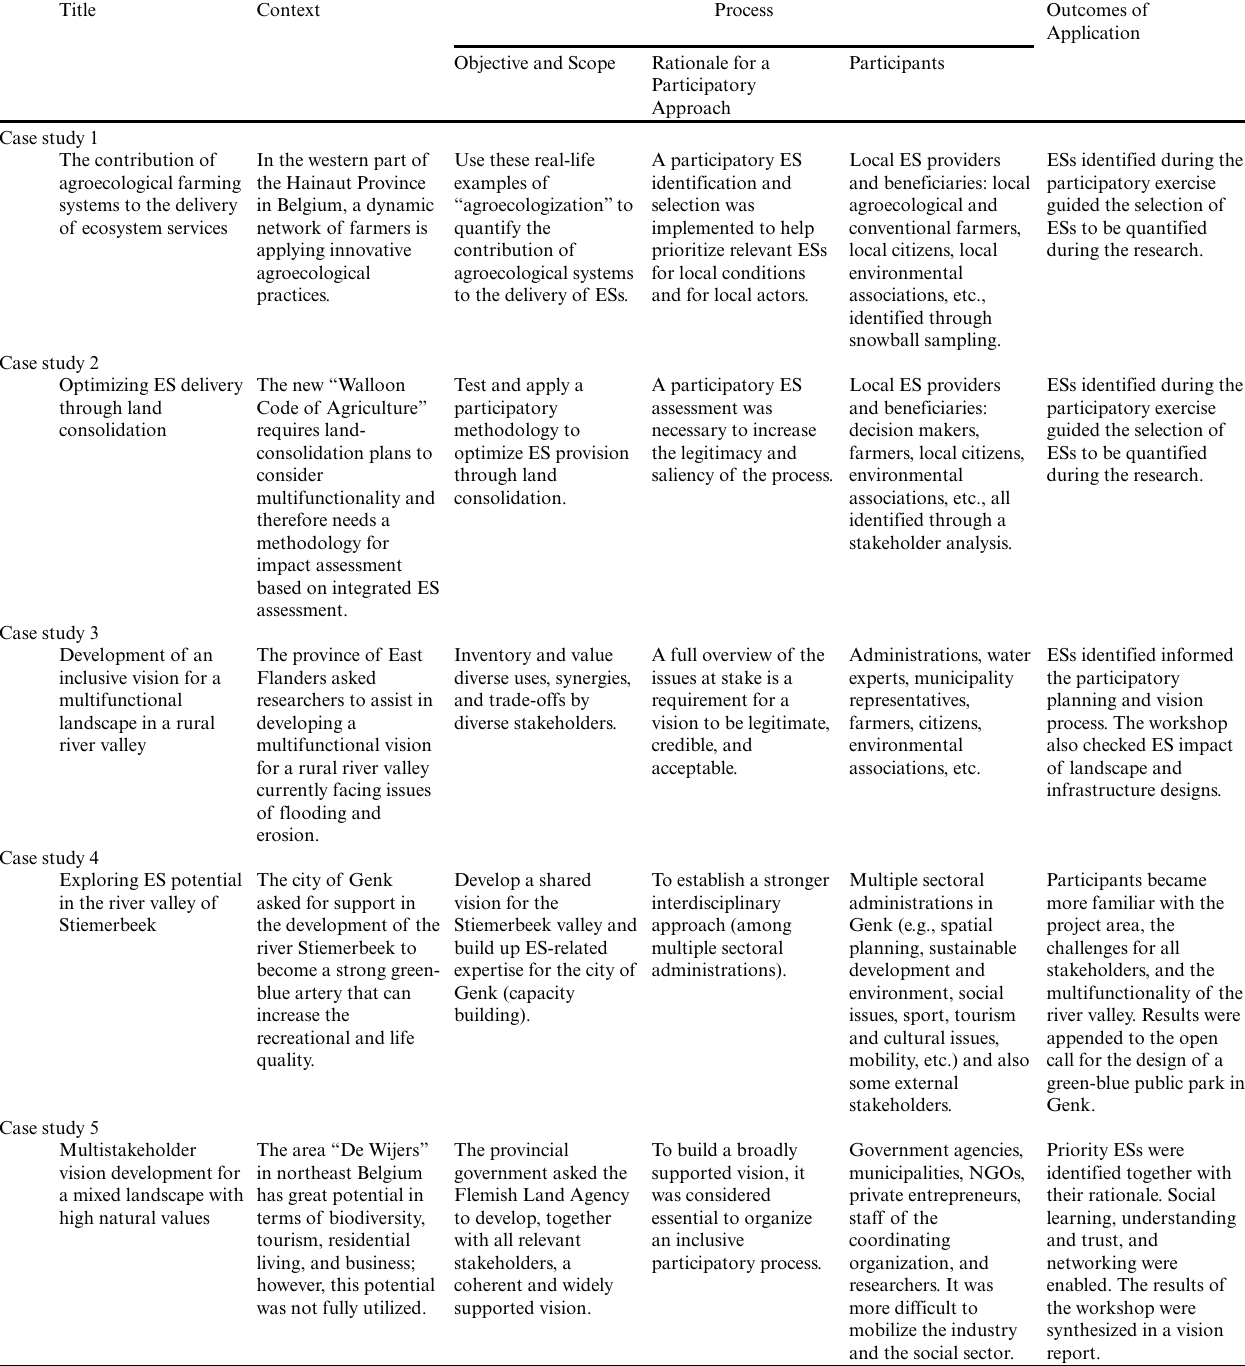
Table 1 . Summary of the five cases studied through the self-evaluation. For more details, see Appendix